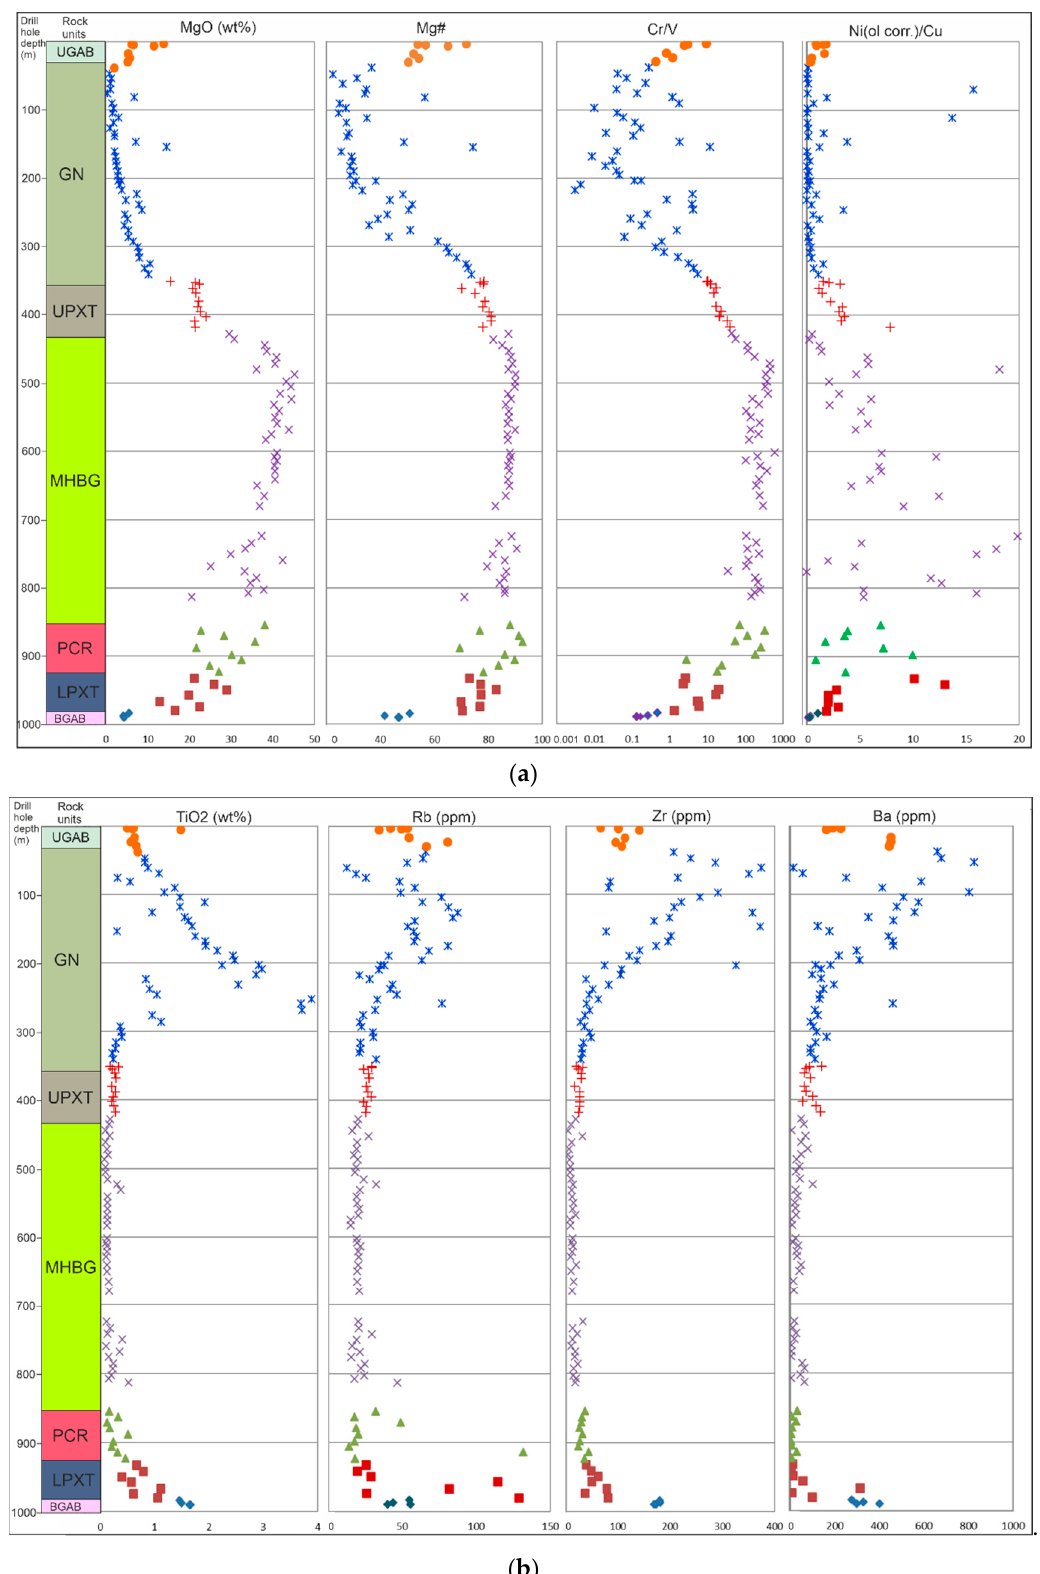
Figure 8. Overall geochemical XRF profile of element(oxide)s and ratios in LM-6. Abbreviations: Rock units as in Figure 5. ( a ) compatible element(oxide) ratios; Mg#: Mg*100/(Mg + Fe 2+ ) in atomic proportions, Ni (ol. corr.)/Cu: For olivine-corrected Nickel/Copper ratio (dimensionless). ( b ) incompatible element(oxide) ratios (dimensionless).